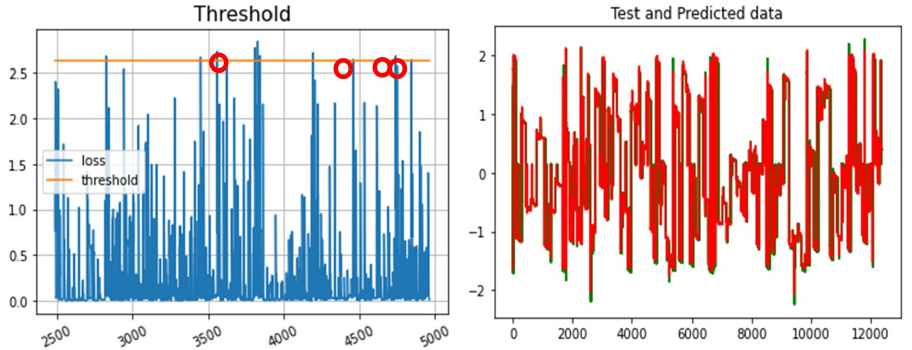
Figure 13. ( left ) Detection threshold for Power System Dataset, ( right ) Prediction of R1-PA4:IH values using LSTM (predicted values (red) and the actual values (green)).